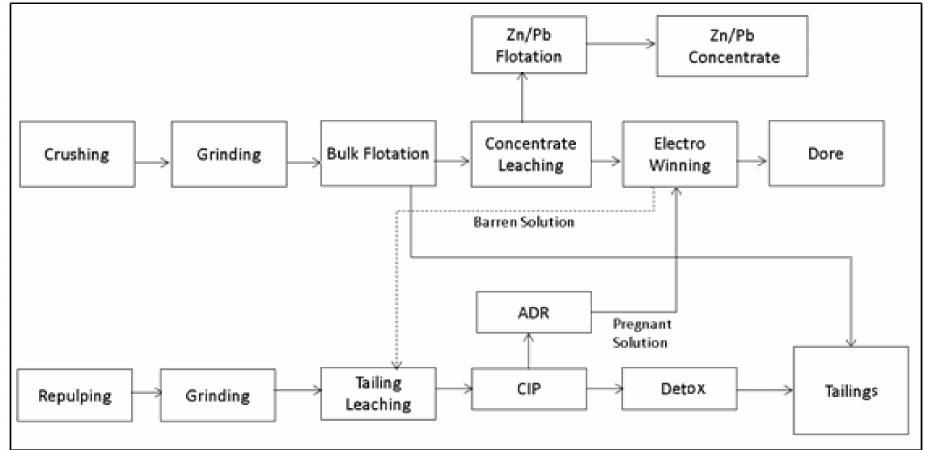
Figure 6. Simplified flowsheet of the mineral processing at the Florida